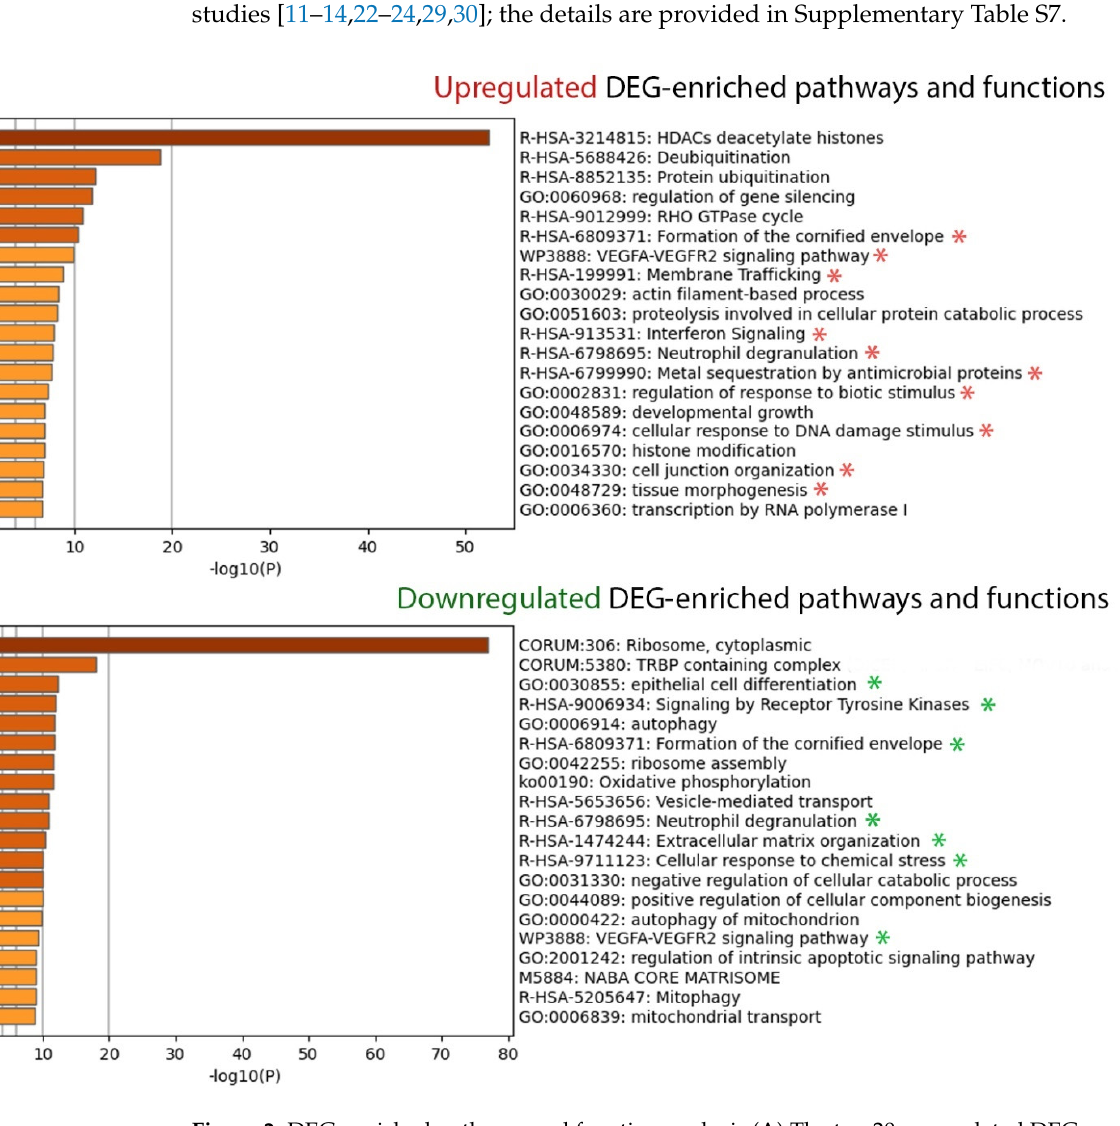
Figure 2. DEG-enriched pathway and function analysis ( A ) The top 20 upregulated DEG-enriched pathways and functions. ( B ) The top 20 downregulated DEG-enriched pathways and functions. A − log10 (10) value is the p -value in log base 10 to create the height of each bar chart. The associated pathways and functions are annotated with *. CORUM, comprehensive resource of mammalian protein complexes; DEG, differentially expressed gene; GO, gene ontology; ko, Kyoto Encyclopedia of Genes and Genomes (KEGG) pathway; M, canonical pathways; R-HSA, reactome gene sets; WP, WikiPathways. Table 2. The potential differentially expressed genes (DEGs).